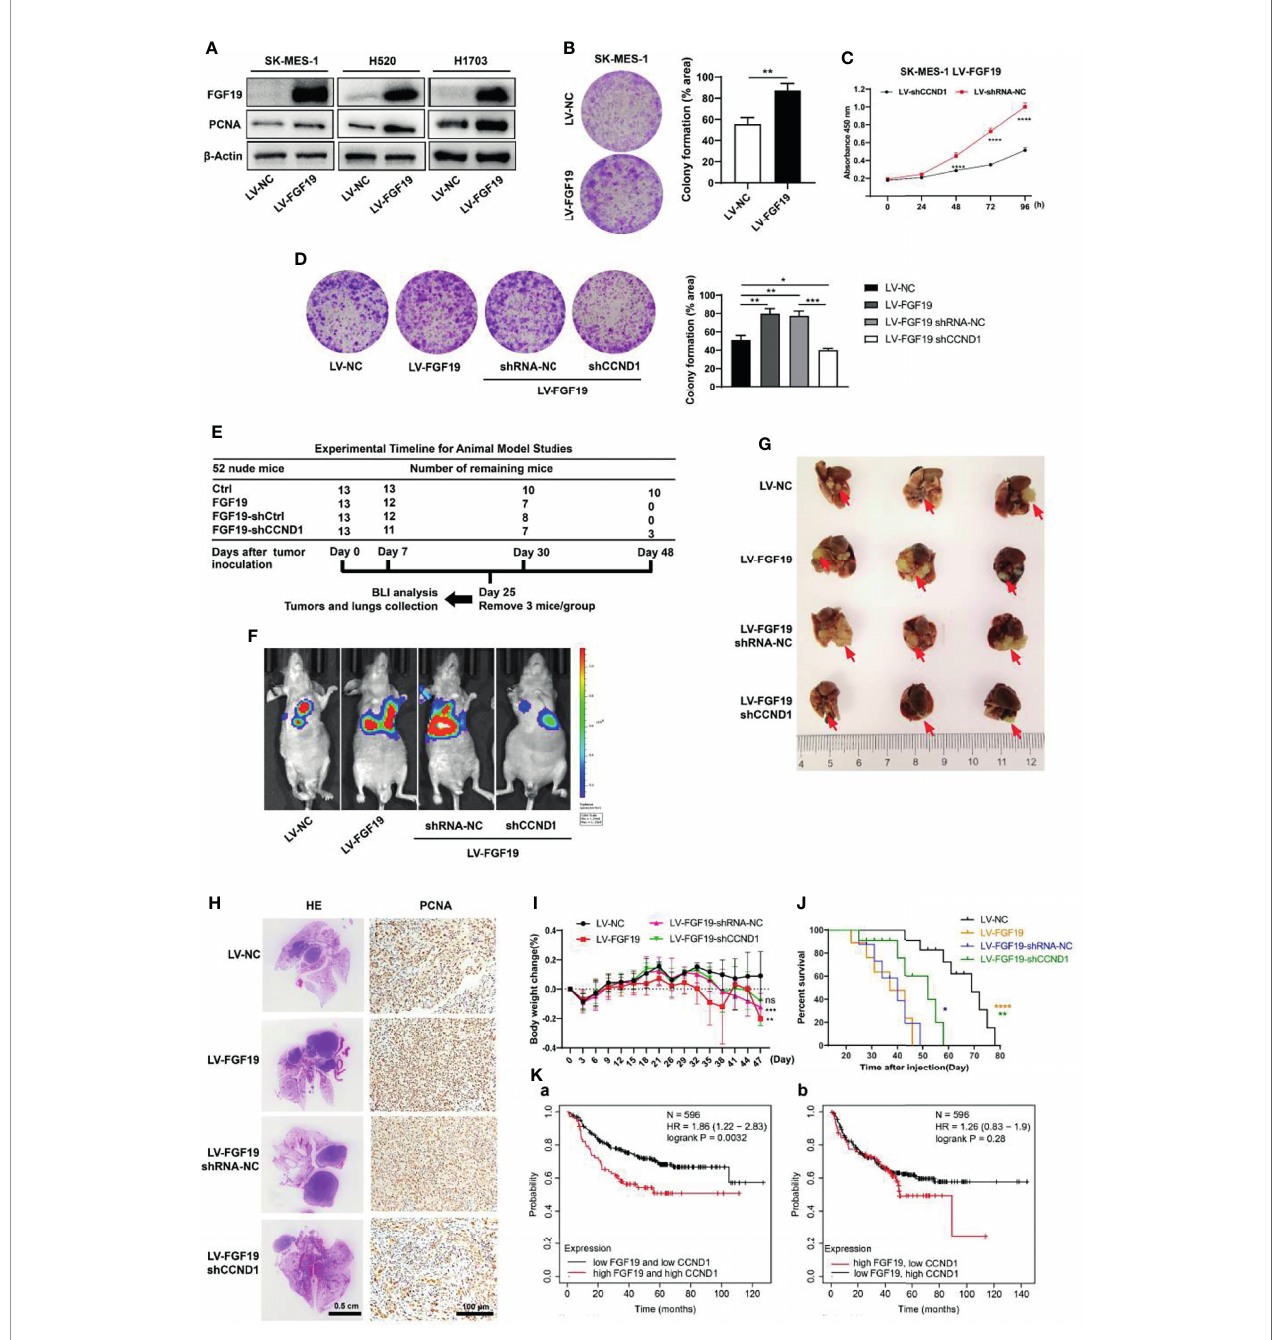
FIGURE 5 | CCND1 is essential for FGF19 signaling-mediated LUSC proliferation. (A) Western blot analysis showing protein levels of FGF19 and PCNA in SK-MES- 1, H520 and H1703 cells after lentivirus transfection. (B) Clone formation assay of SK-MES-1 cells with or without FGF19 overexpression. (C) Cell proliferation was measured by CCK8 assay in SK-MES-1 LV-FGF19 cells with or without CCND1 knockdown. (D) Clone formation assay of SK-MES-1 LV-FGF19 cells with or without CCND1 knockdown; cultures were stained with crystal violet. (E – J) Data of orthotopic lung cancer model. Cell suspension of SK-MES-1 LV-NC/LV-FGF19/